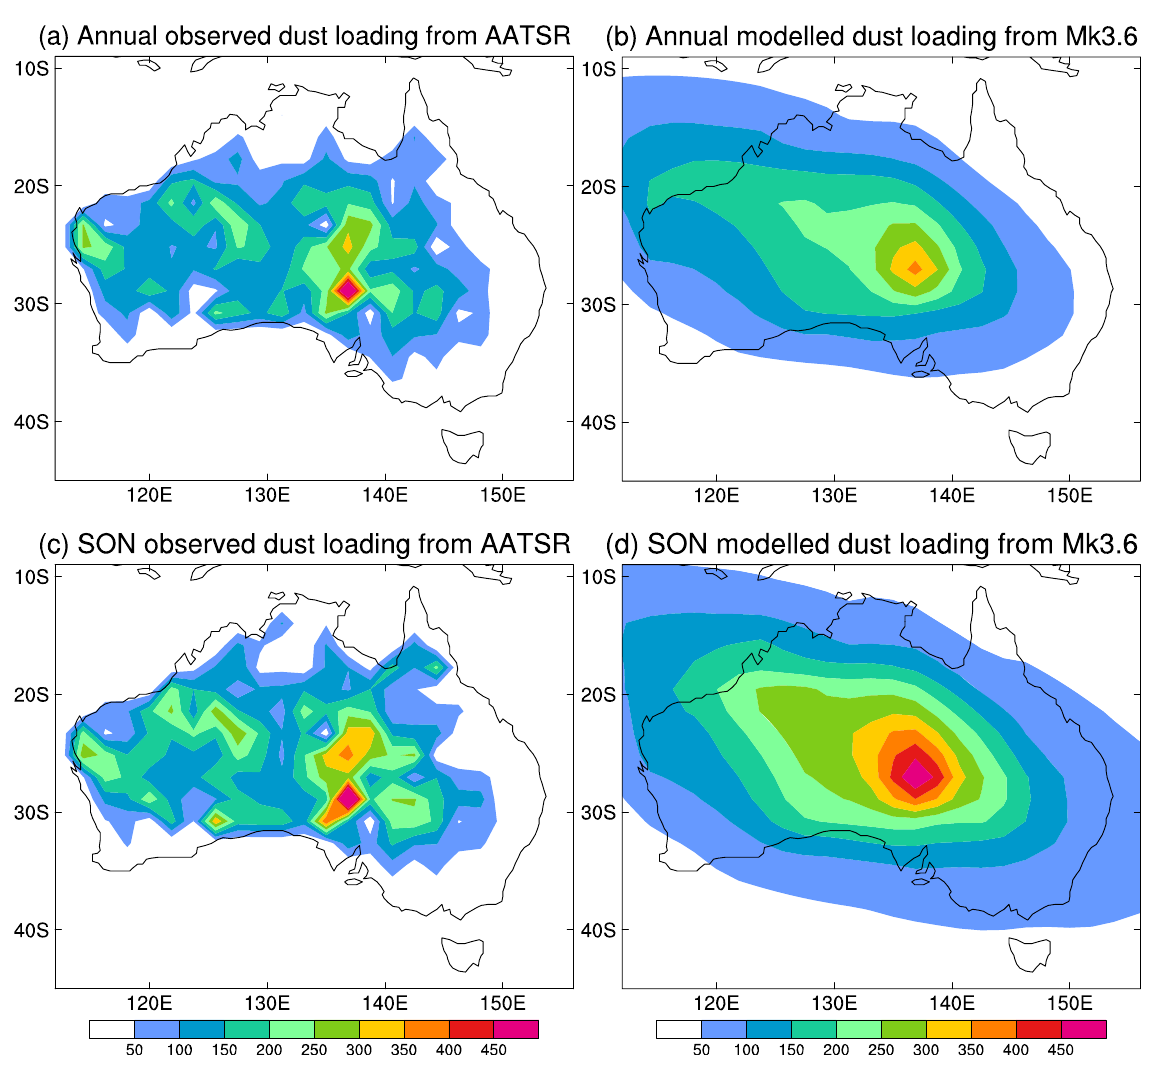
Fig. 2. Dust load over Australia (a) observed annual means, (b) simulated annual means, (c) observed for SON, (d) simulated for SON (in mgm − 2 ). Observations cover the period September 2002 to August 2007 for annual means, and September 2002 to November 2007 for